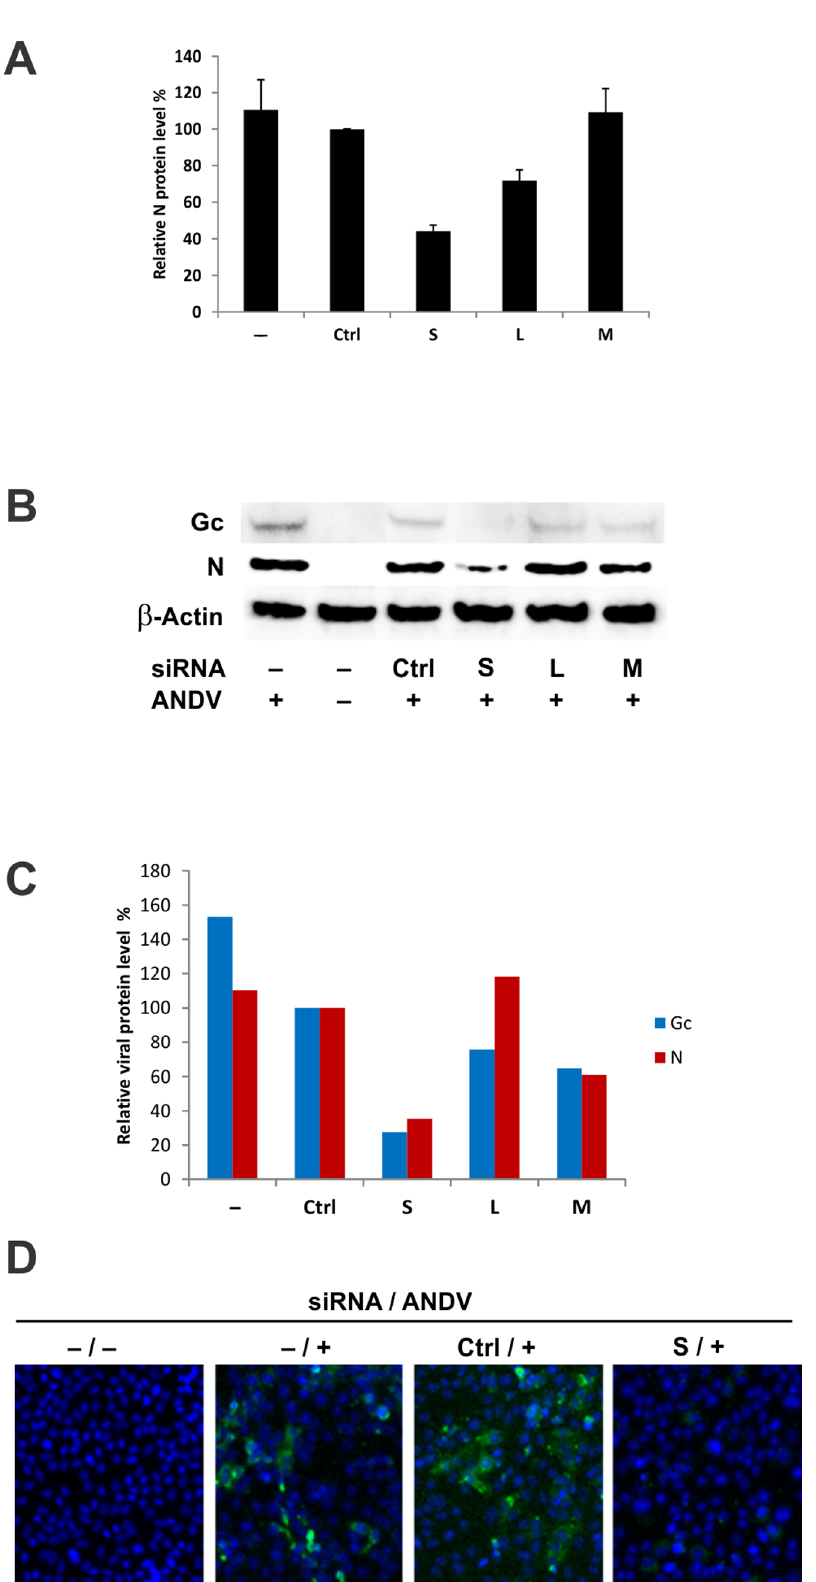
Figure 1. siRNA inhibits ANDV protein synthesis. Vero-E6 cells were transfected with 100 nM of either scrambled siRNA (Ctrl) or pools of siRNAs targeting the small (S), large (L), or medium (M) segment of ANDV using DharmaFECT 1. After 6 h, siRNAs were removed, and cells were infected with ANDV at multiplicity of infection (MOI) =0.5 for 48 h. (A) Cells were lysed, and expression of the N protein was quantitated by an immunolabeling assay. (B) The levels of Gc glycoprotein, N protein, and b -actin were analyzed by Western blotting, and quantified by densitometry. (C) Data are